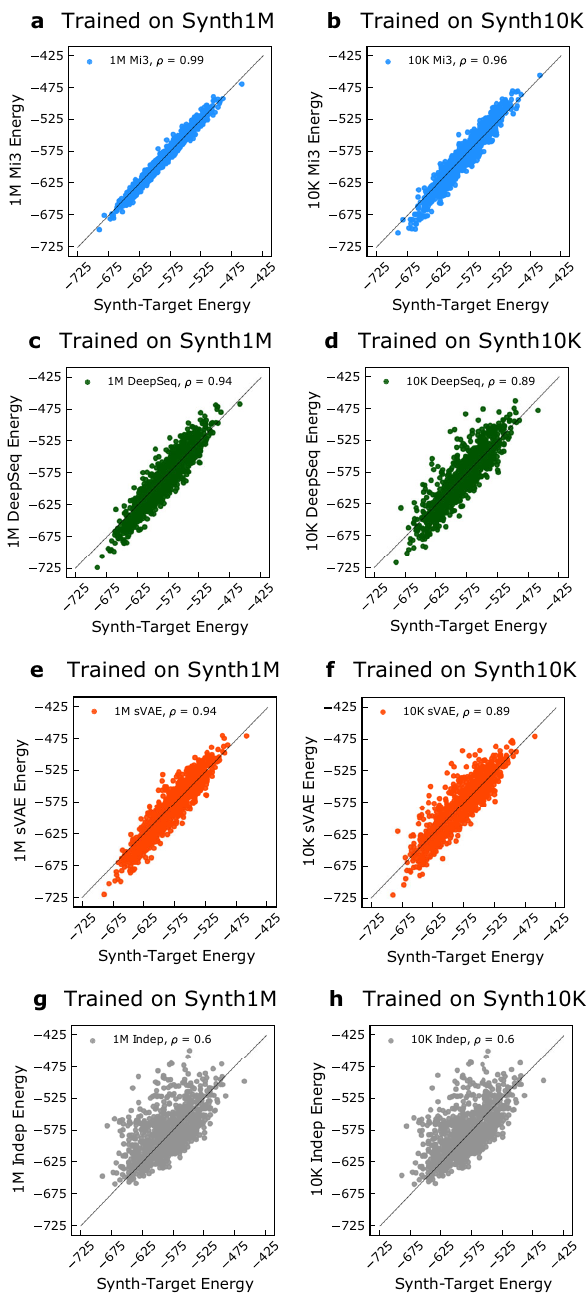
Fig. 5 Ability of GPSMs to capture statistical energy, E ( S ). Statistical energies E ( S ) of 1K synthetic test sequences from the target probability distribution as evaluated by Mi3 (blue, a , b ), DeepSequence (green, c , d ), sVAE (orange, e , f ), Indep (gray, g , h ). Each GPSM was trained on 1M (Synth1M, a , c , e , g ) or 10K (Synth10K, b , d , f , h ) sequences from the synthetic target probability distribution. For each scatterplot, Pearson correlation coef fi cient ρ was computed between each GPSM ’ s statistical energy and that of the synthetic target probability distribution for each sequence. Only Indep is insensitive to decreased training sample size for this